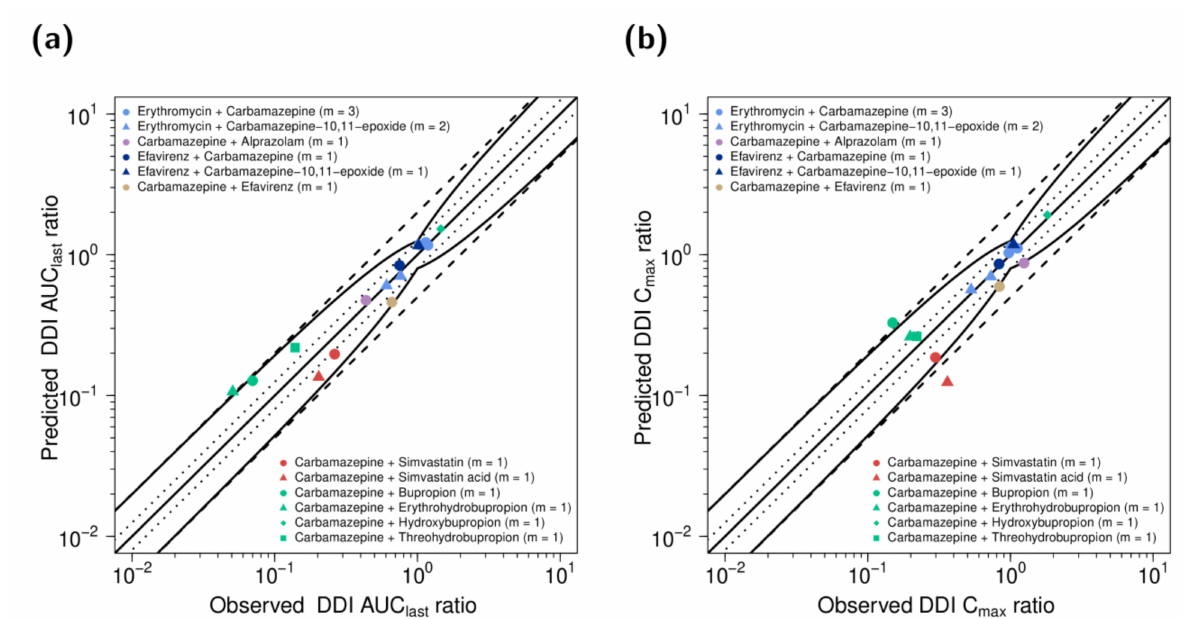
Figure 6. DDI performance of the carbamazepine parent − metabolite PBPK model. Predicted compared to observed ( a ) DDI AUC last ratios and ( b ) DDI C max ratios of all analyzed DDI studies. Dots represent the victim drug; triangles, diamonds and squares of the same color represent respective metabolites. The line of identity is shown as a straight solid line; the curved solid lines mark the prediction success limits proposed by Guest et al. [33]. A 1.25-fold deviation is shown as dotted lines; 2-fold deviation is shown as dashed lines. Details on the study protocols and all individual DDI AUC last and DDI C max ratios are provided in the Supplementary Materials. AUC last : area under the plasma concentration − time curve from dosing to the last concentration measurement, C max : maximum plasma concentration, DDI: drug–drug interaction, m: number of